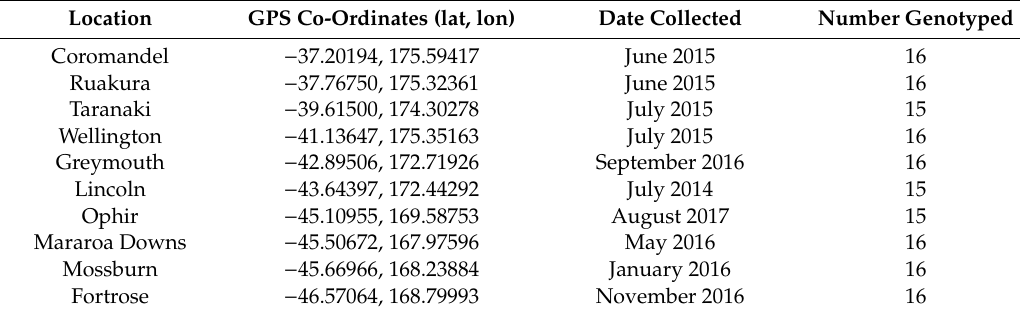
Table 1. Weevil collection locations (see also Figure